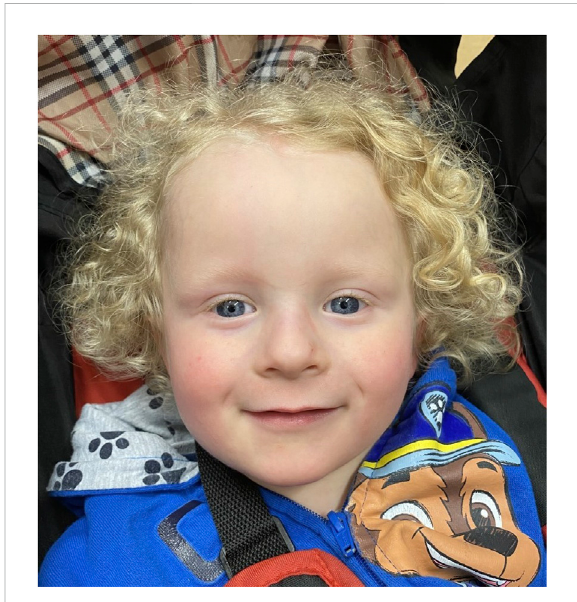
FIGURE 1 Clinical features of the patient described in this report at 4 years of age. The child showed fi ne, thin, curly hair with high anterior hairline and broad forehead, sparse eyebrows, epicanthus to left palpebral fi ssure and a thin upper